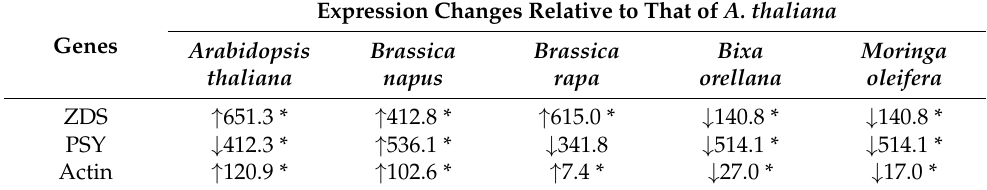
Table 2. ZDS and PSY gene expression using quantitative real-time PCR in Brassica napus, Brassica rapa, Brassica oleracea and Bixa orellana .